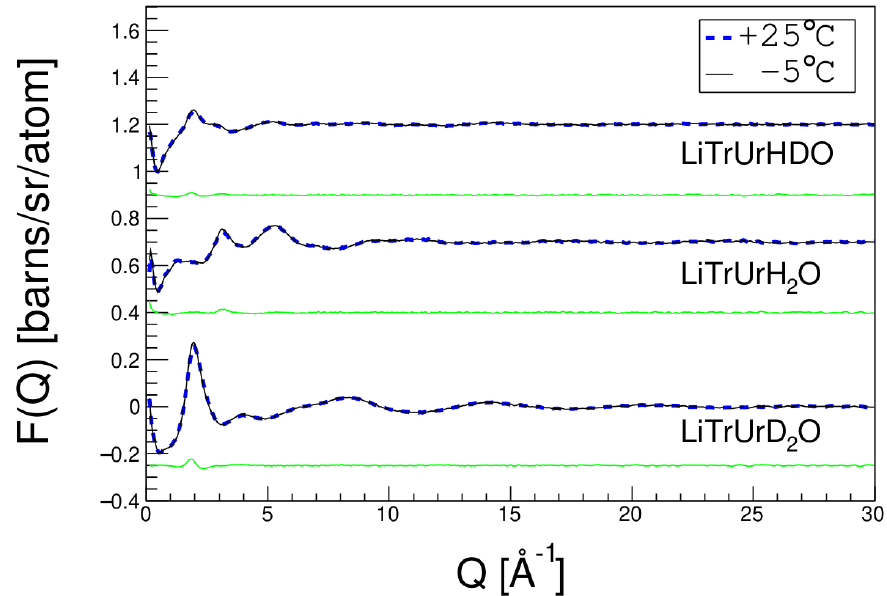
Figure 8. Neutron total scattering profiles of trehalose in LiOH/urea aqueous solution at 25 °C and −5 °C and the difference between them (green lines).